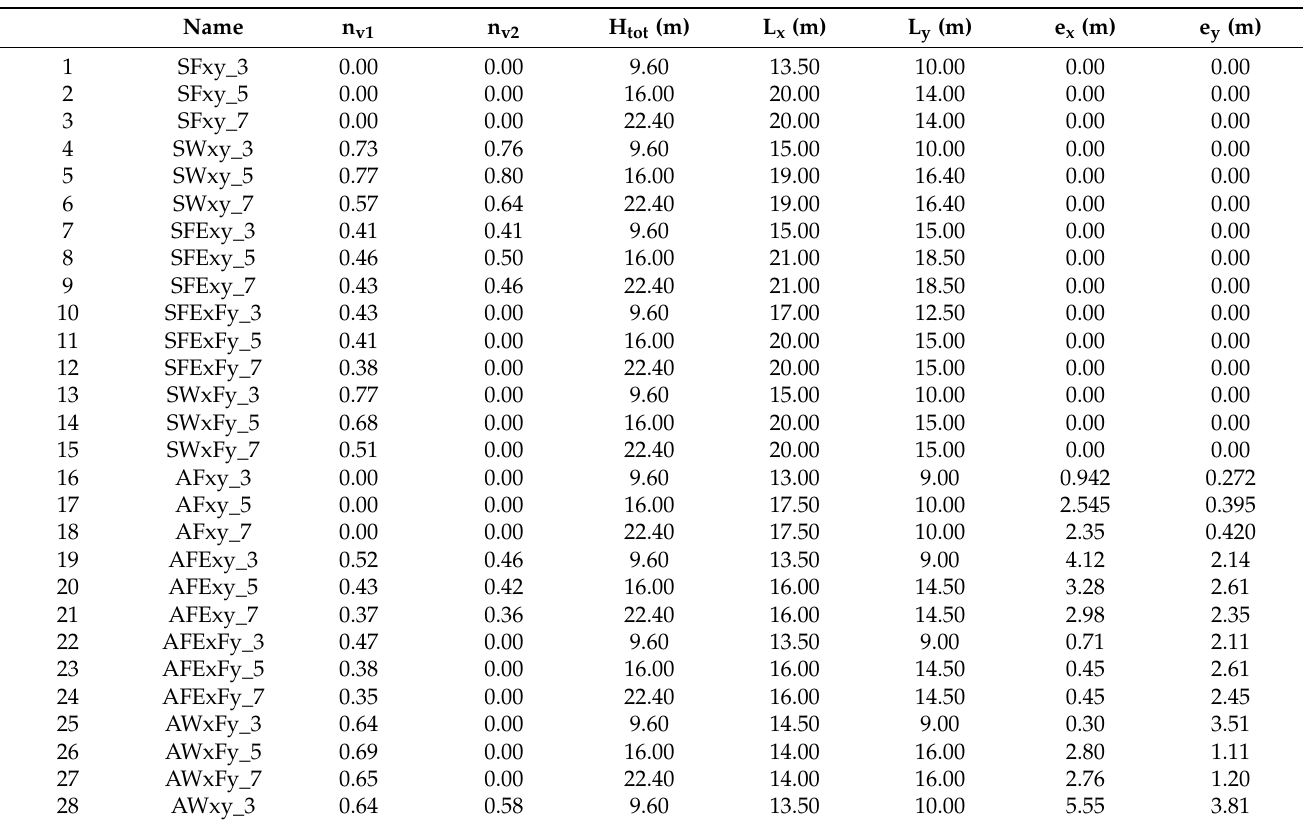
Table 8. Structural data of the 30 examined known RC buildings used for the prediction of their